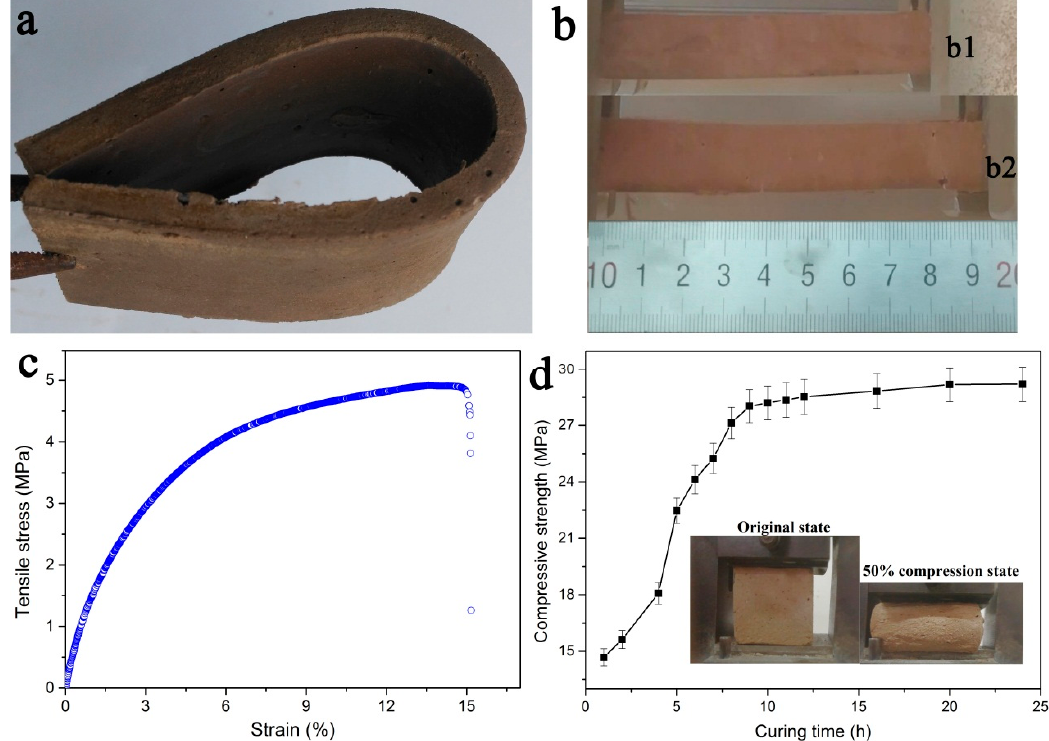
Figure 2. Flexible and mechanical properties of cured PRC. ( a ) A photograph of bending PRC specimen. ( b ) Uniaxial tension test of cured PRC: ( b1 ) original state and ( b2 ) tensional state. ( c ) Typical stress-strain curve of specimen during the stretching process. ( d ) The compressive strength as a function of curing time. Average of three measurements (mean ± S.D.) The inset photographs display the original and 50% compression status of cured PRC.